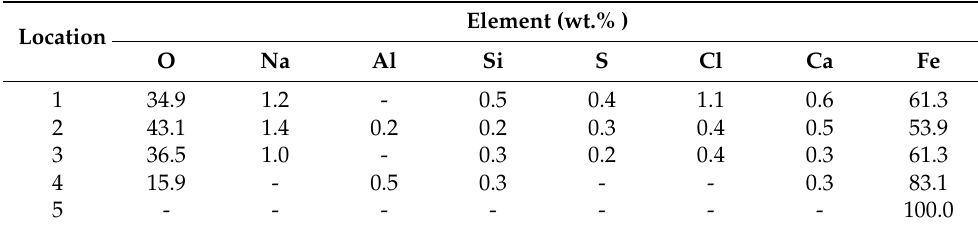
Table 8. Elemental analysis from locations in Figure 7.